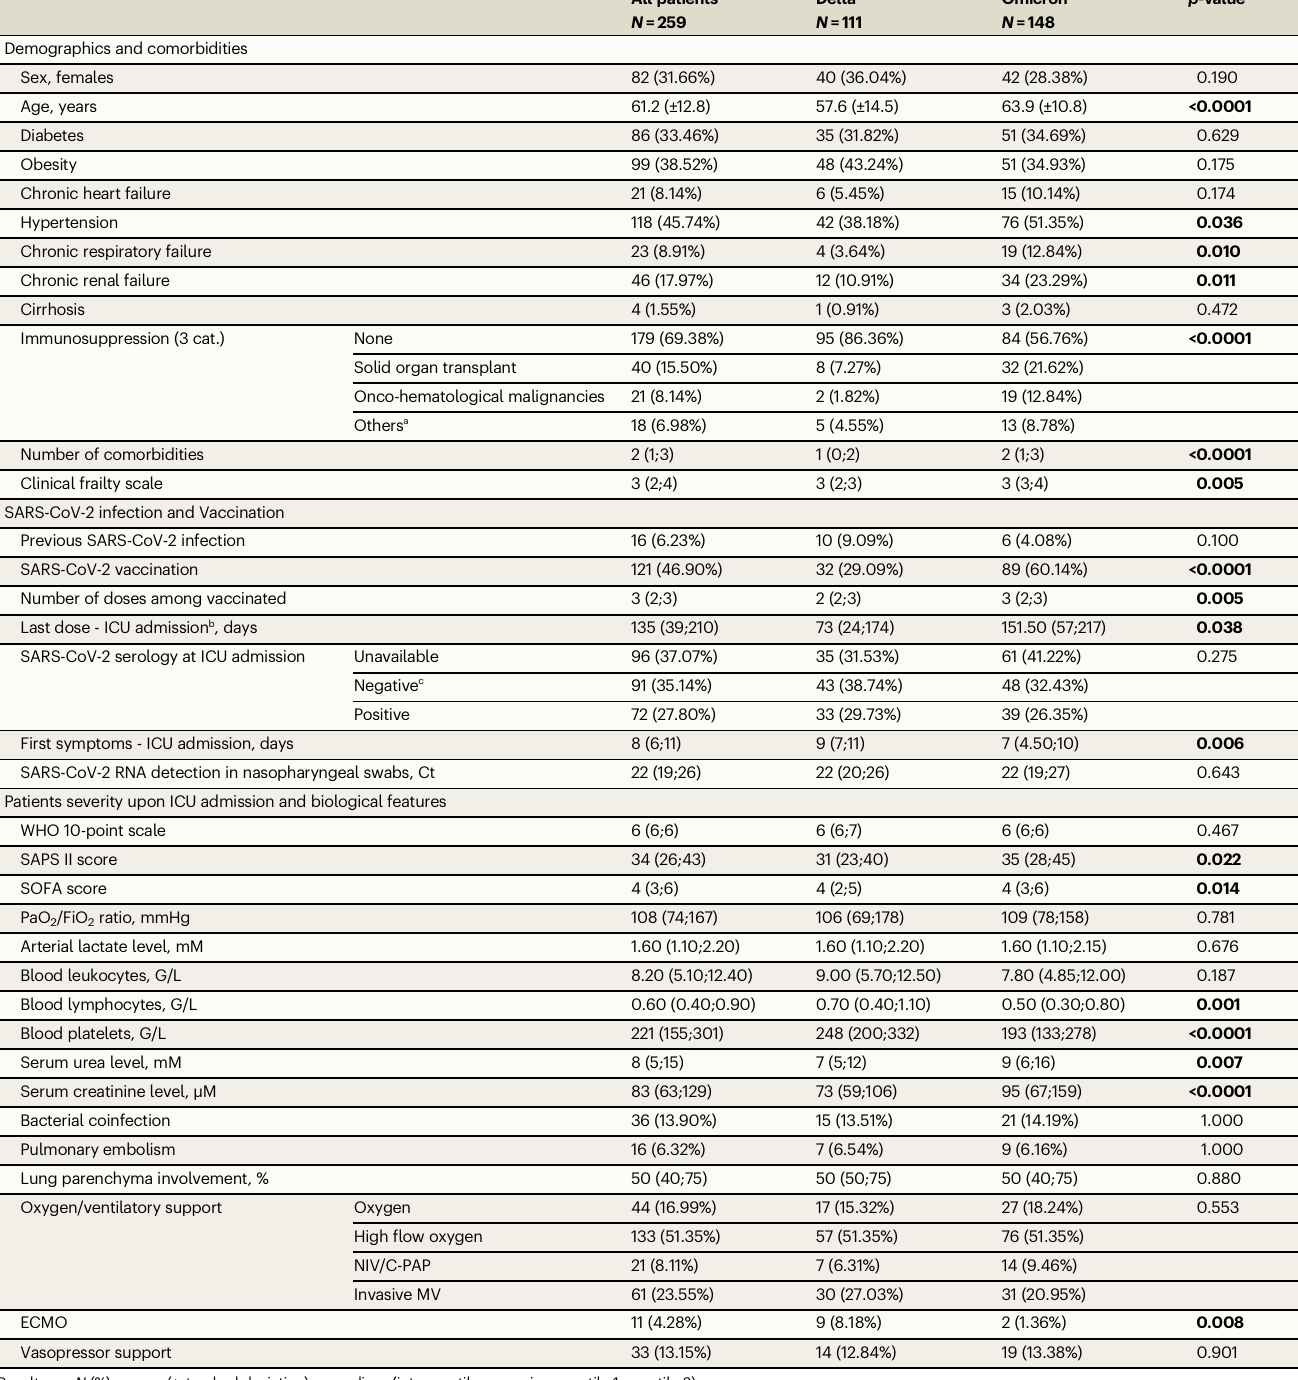
Table 1 | Clinical and biological characteristics of the 259 patients with severe SARS-CoV-2 infection at the time of their intensive care unit admission according to the infecting SARS-CoV-2 variant (Delta vs Omicron) All patients Delta Omicron p -value N =259 N